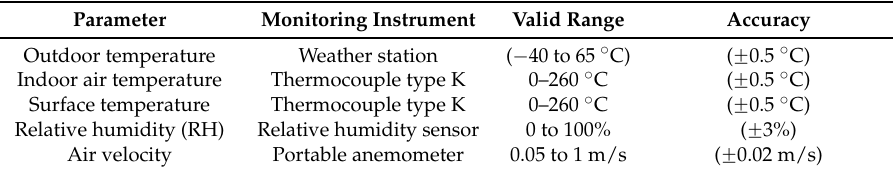
Figure 3. Sensor locations in the office. Table 2. Monitoring parameters and specification of monitoring